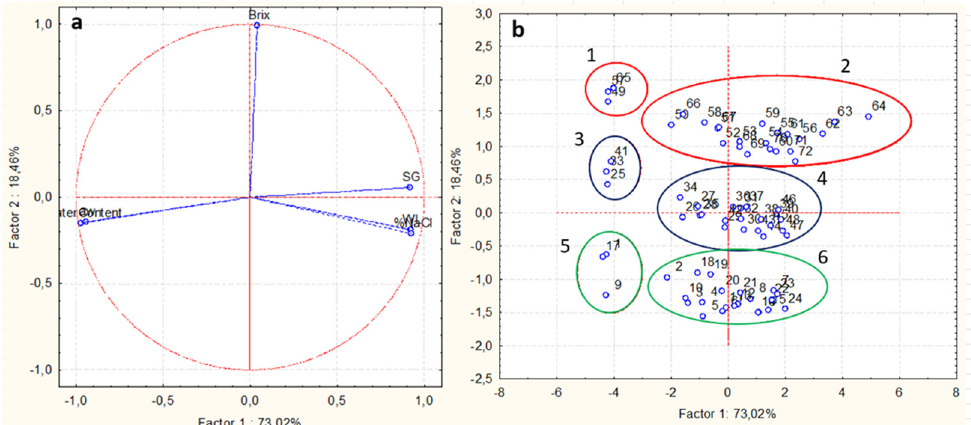
Figure 6. Principal component analysis (PCA) to investigate the interrelationship between water loss (WL), solid gain (SG), moisture content (MC), °Brix, %NaCl, and water activity (a w ) with the osmotic solution formulations (osmotic concentration) and process conditions (temperature, time). ( a ): Loading plot. ( b ): Score plot, where the distinct sample groups are numbered (1 to 6) and shown in different colors.